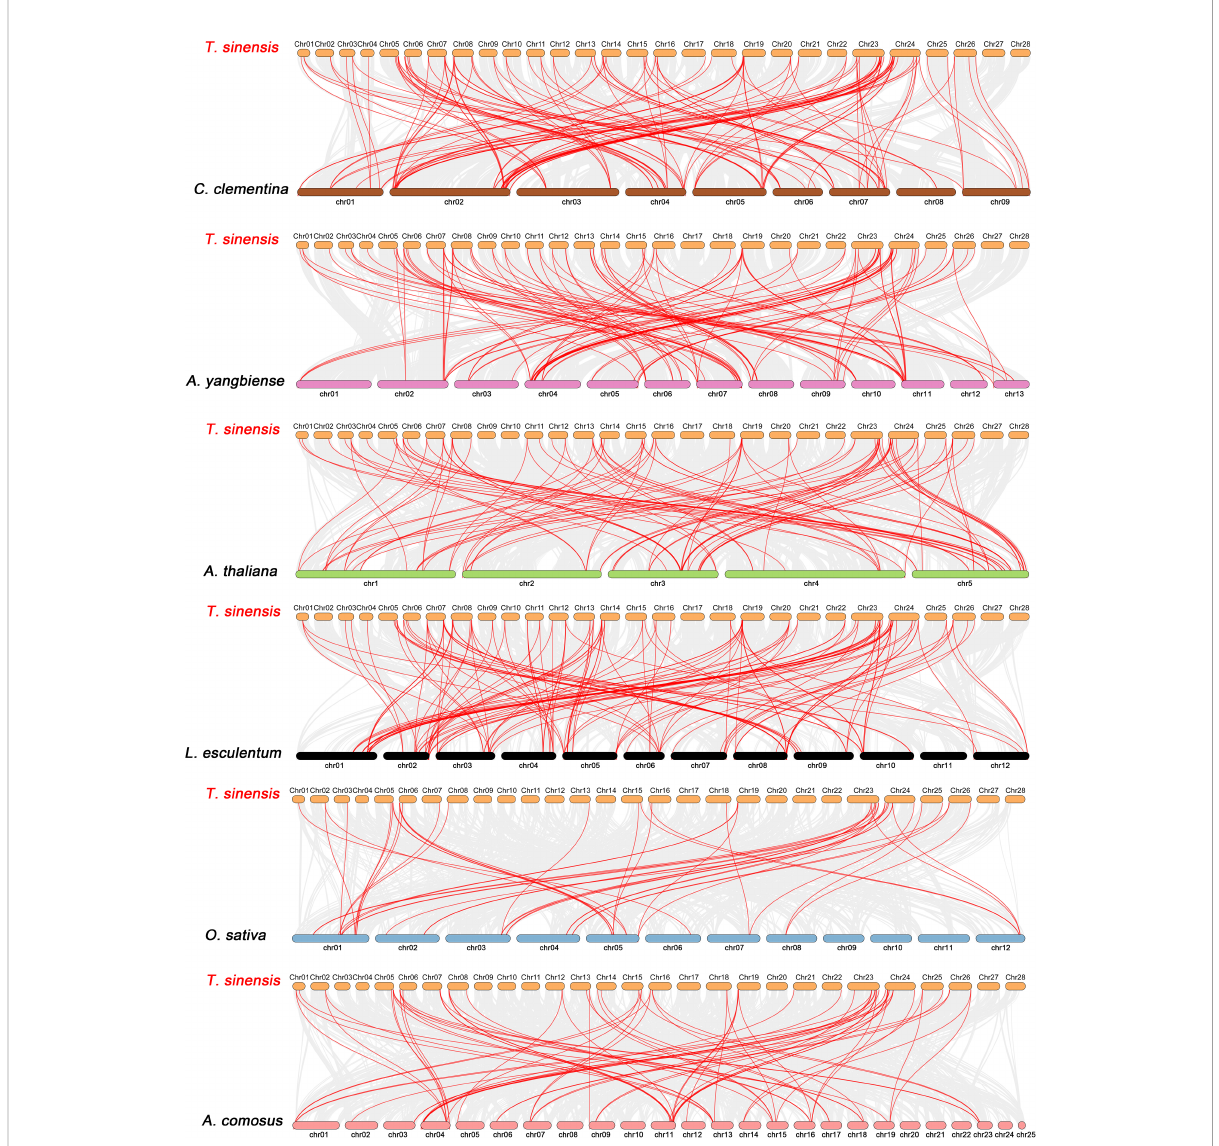
FIGURE 6 Synteny analysis of WRKY genes between T. sinensis and six representative plant species: Citrus clementina ( C. clementina ), Acer yangbiense ( A. yangbiense ), Arabidopsis thaliana ( A. thaliana ), Lycopersicon esculentum ( L. esculentum ), Oryza sativa ( O. sativa ), and Ananas comosus ( A. comosus ). Every horizontal bar indicates a different chromosome. The red curves represent the syntenic WRKY gene pairs, whereas the gray lines indicate the collinear blocks within T. sinensis and other plant